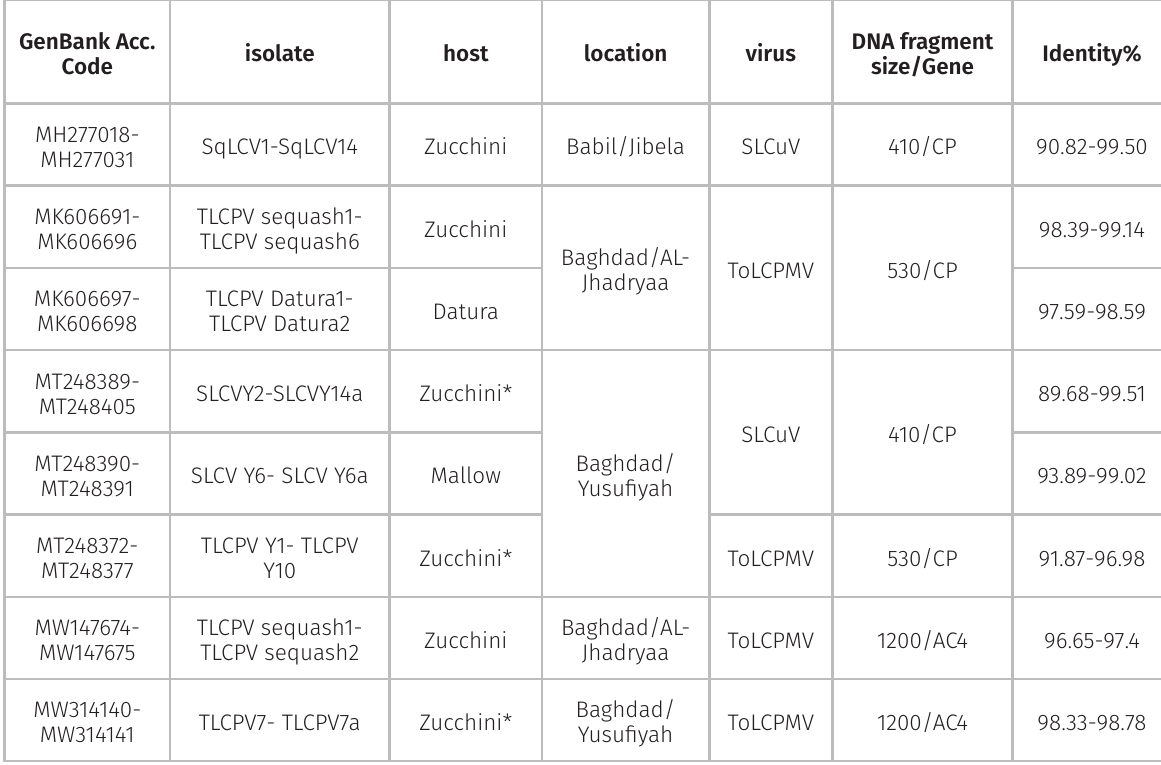
DNA fragment size/Gene